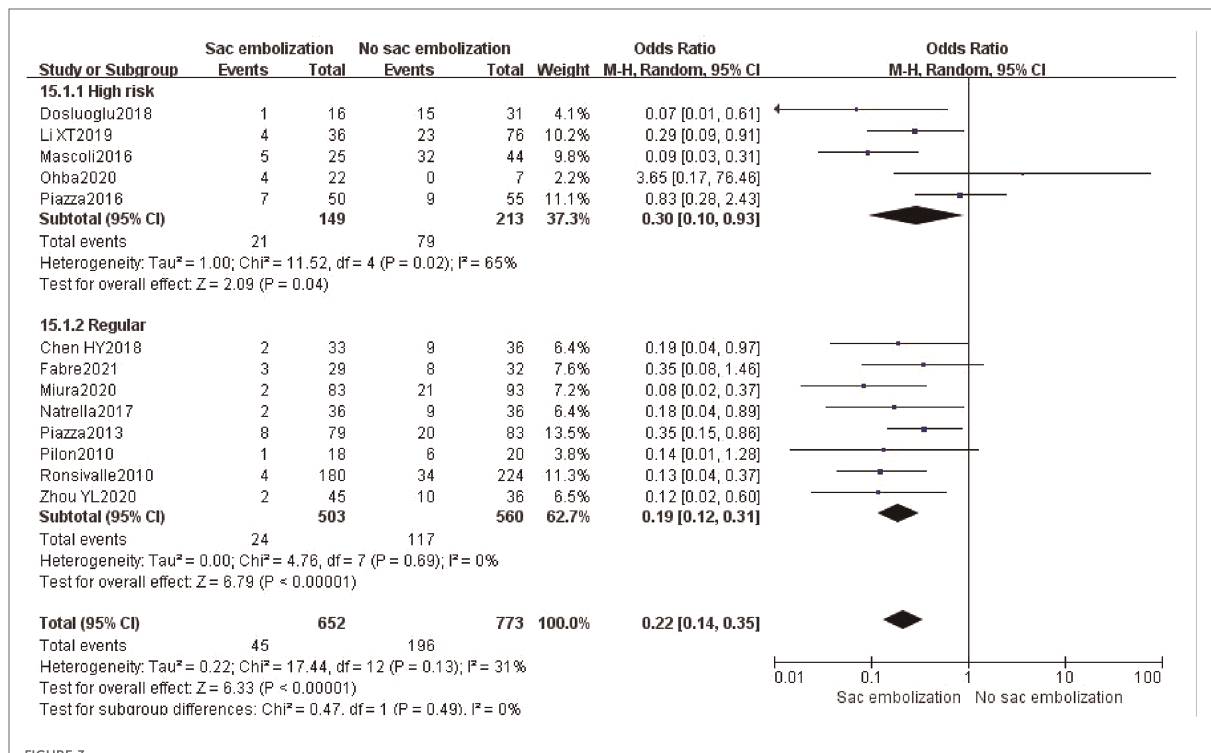
FIGURE 3 Incidence of type II endoleak at the last follow-up in the high risk group compare with the regular